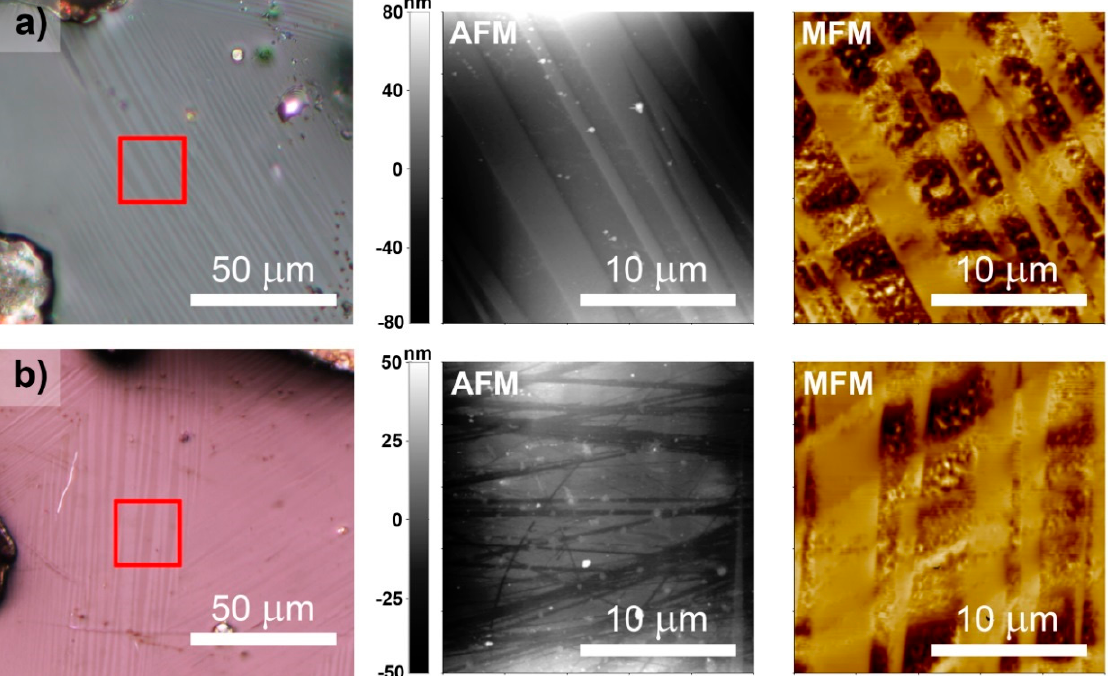
Figure 7. Optical micrographs (left) and corresponding AFM (middle)/MFM (right) scans of the red squares of the left micrographs for the 1080 °C (row ( a )) and 1090 °C (row ( b )) sintered samples at twin-dense regions. The square red regions are 20 μ m × 20 μ m as indicated in the AFM/MFM micrographs.